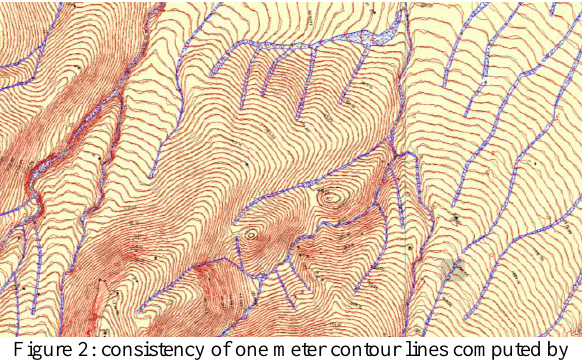
Figure 2: consistency of one meter contour lines computed by field surveying (blue and black lines) and UAV photogrammetry (red